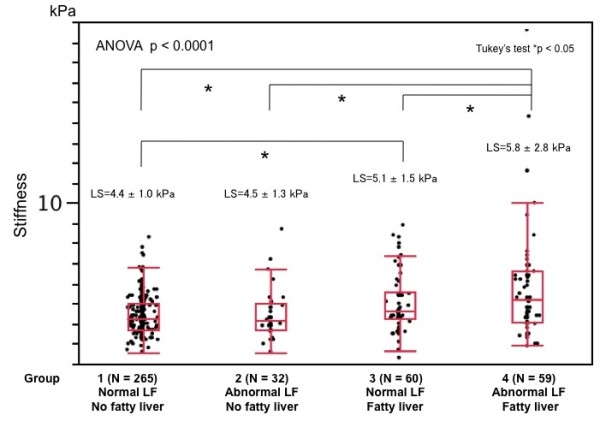
Comparison of liver stiffness among four groups based on liver dysfunction and fatty liver. Liver stiffness significantly differed among these groups. Liver stiffness was highest in Group 4 and that of Group 3 was higher than that of Group 1 according to multiple comparisons (Tukey's test).